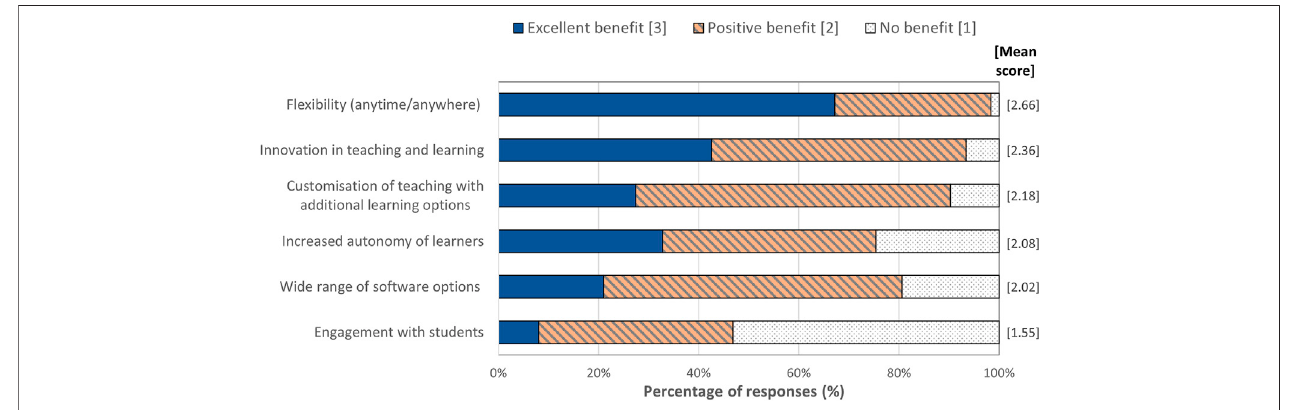
FIGURE 4 | Positive aspects of online/distance learning.